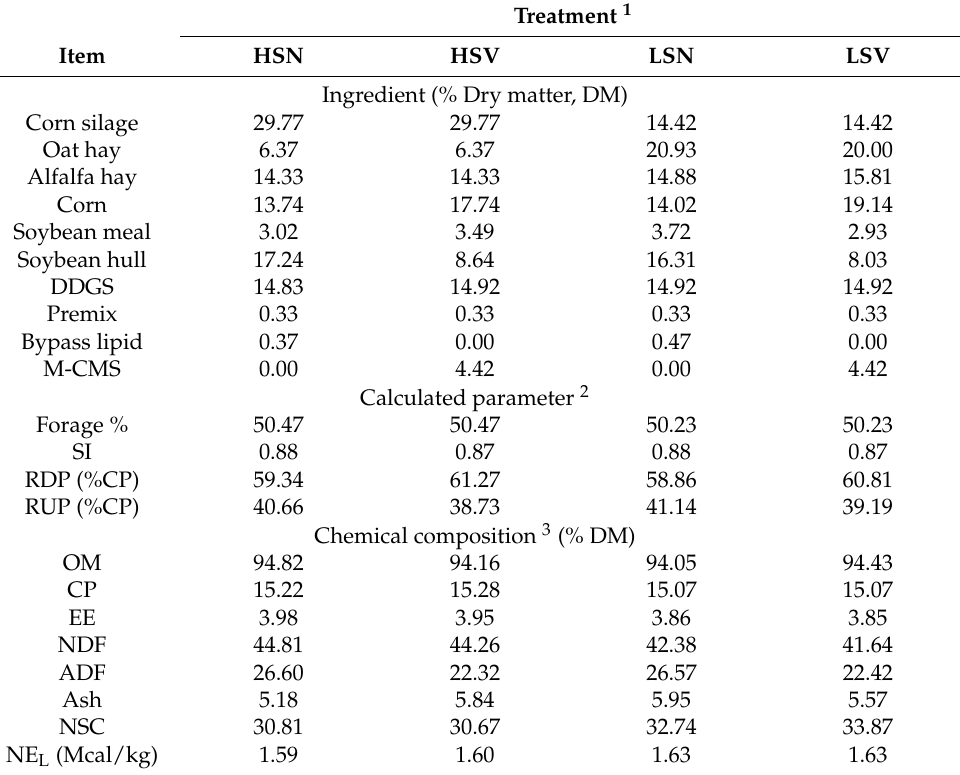
Table 2. Composition of diets for Experiment 2 (M-CMS supplementation with different corn silage